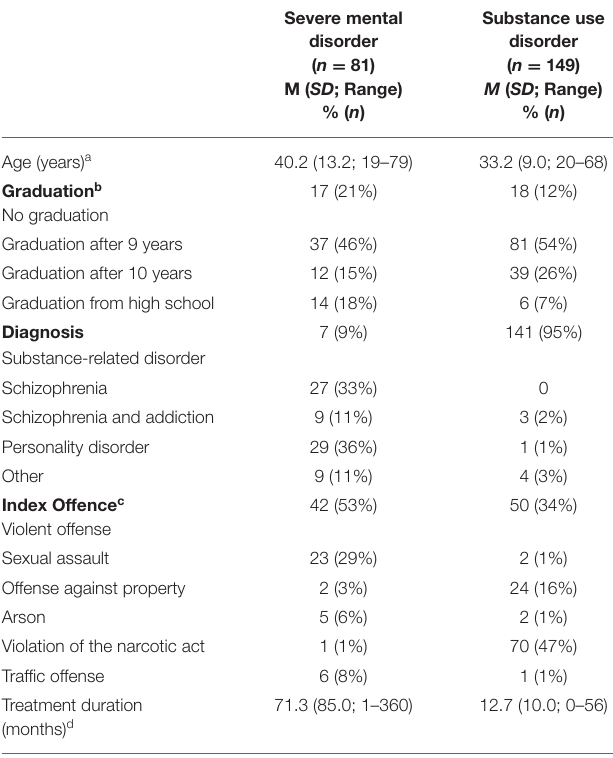
TABLE 1 | Sociodemographic and forensic-psychiatric characteristics of the participants.